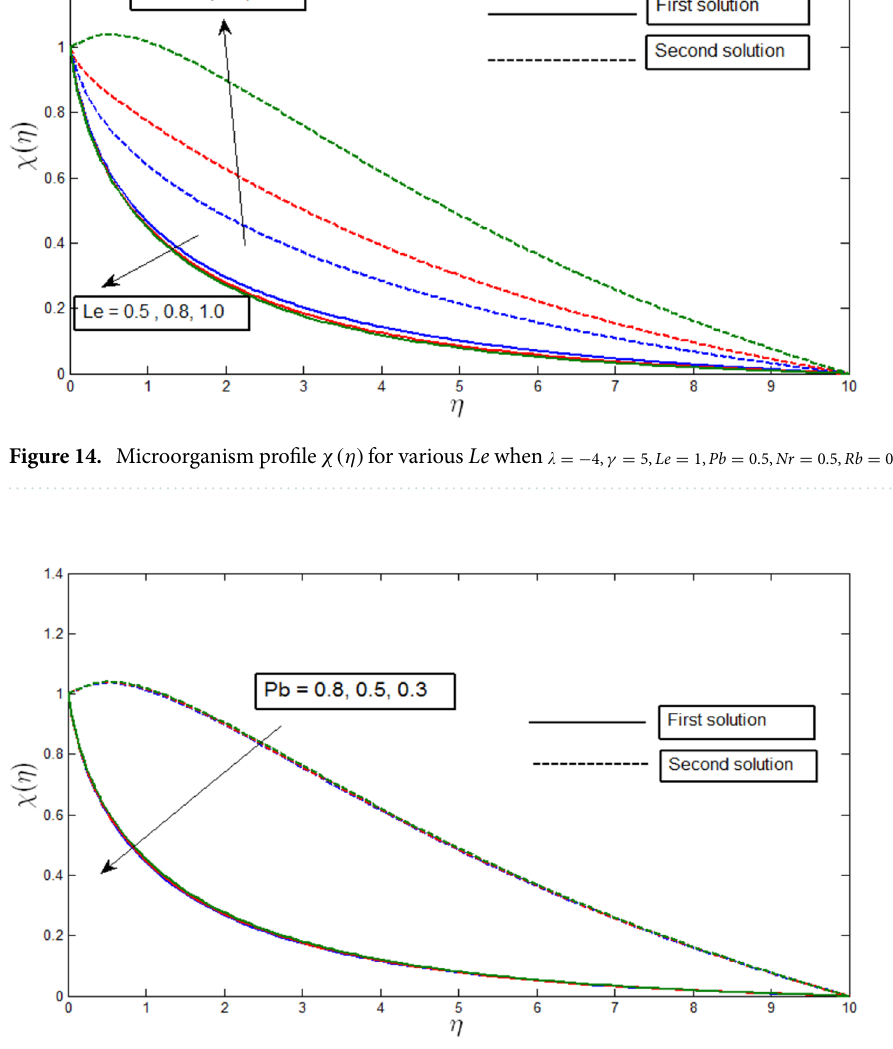
Figure 15. Microorganism profile χ(η) for various Pb when (cid:31) = − 4, γ = 5, Le = 1, Nr = 0.5, Rb = 0.6, A =